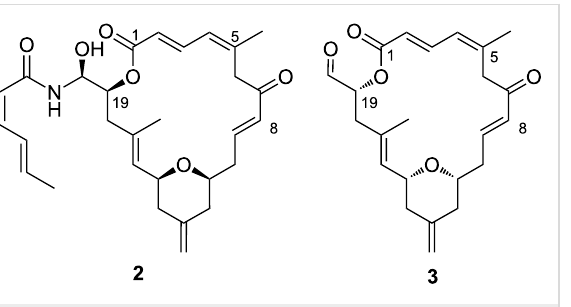
( − )-Zampanolide ( 2 , Figure 1) was first isolated from the marine sponge Fasciospongia rimosa found at Cape Zampa, Japan [21], and subsequently from a Tongan sponge Cacospongia mycofijiensis [22]. It was found to exhibit potent anticancer activities, with IC 50 values in the nM scale against a number of cell lines [22,23]. The structurally related compound, (+)-dactylolide, was discovered in the marine sponge Dacty- lospongia [24] and has significantly lower cytotoxicity. The absolute configuration of the natural material is not firmly established due to discrepancies in optical rotation values between natural and synthetic samples